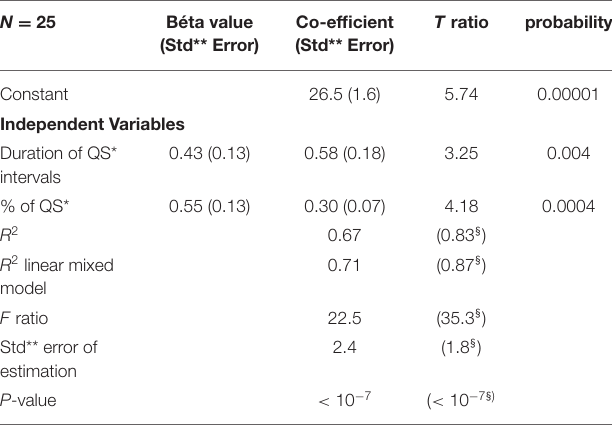
TABLE 3 | Results of multiple linear regression analyses estimated brain-age from quiet sleep characteristics against post-menstrual age (PMA = gestational age + postnatal